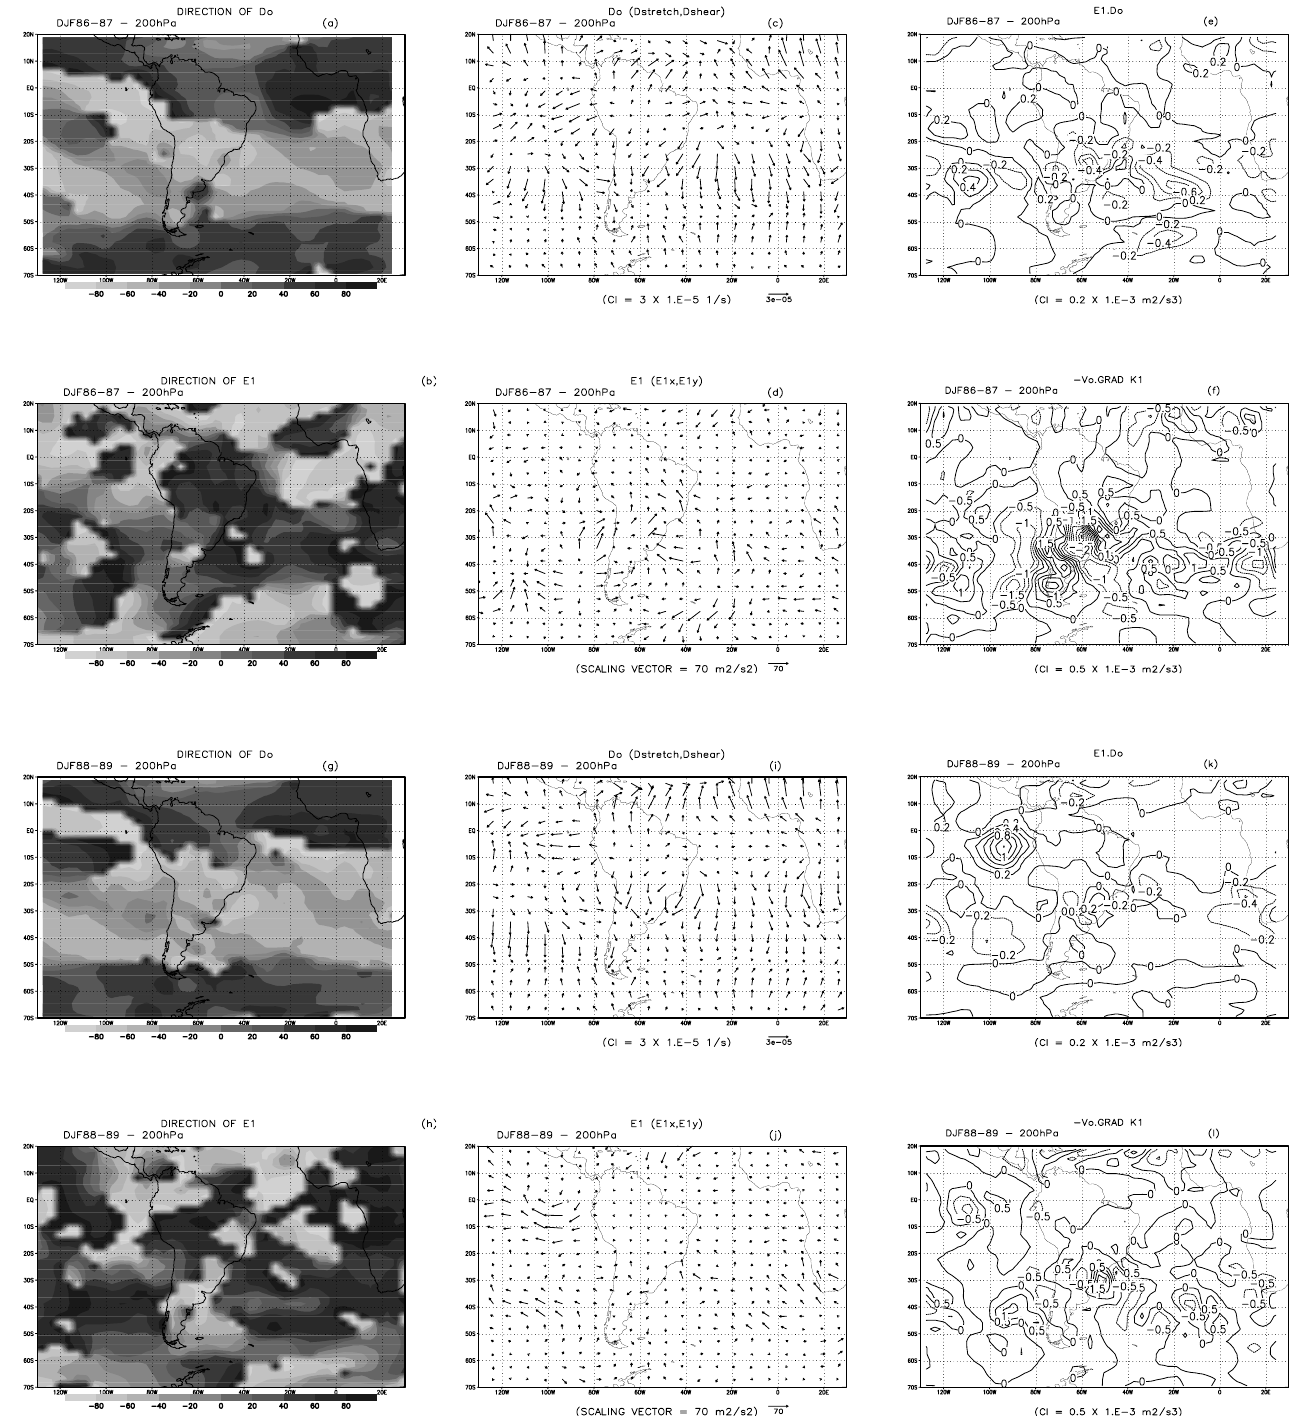
Fig. 7. In the upper six panels the episodal average of summer of 1986–1987 is shown for direction of the vectors: (a) D 0 , (b) E 1 , (c) D ( D st , D sh ) , (d) E 1 (E 1 ,x ,E 1 ,y ) , and (e) the spatial distribution of the local barotropic energy generation rate ( E 1 · D 0 ) as well as (f) the spatial field ( − V 0 · ∇ ) h K 1 i . Analogous to (a) – (f) the situation for the summer of 1988–1989 is presented in lower panels (g) – (m) . SAT term means that the maximum episodic K 1 is generated by baroclinic processes essentially by term h − V 1 · ∇ 8 1 i , while SAT redistributes energy K 1 . A similar but weaker pattern is observed in the summer of